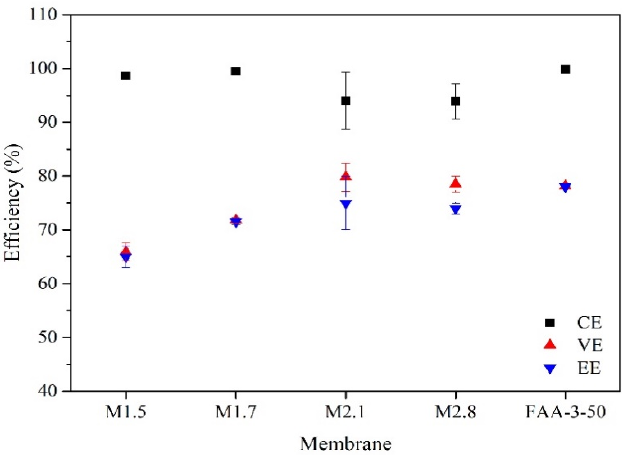
Figure 7. CE, VE and EE of the prepared AEMs and commercial membrane FAA-3-50 ® operated at 80 mA·cm −2 for 100 cycles. 80 mA · cm − 2 for 100